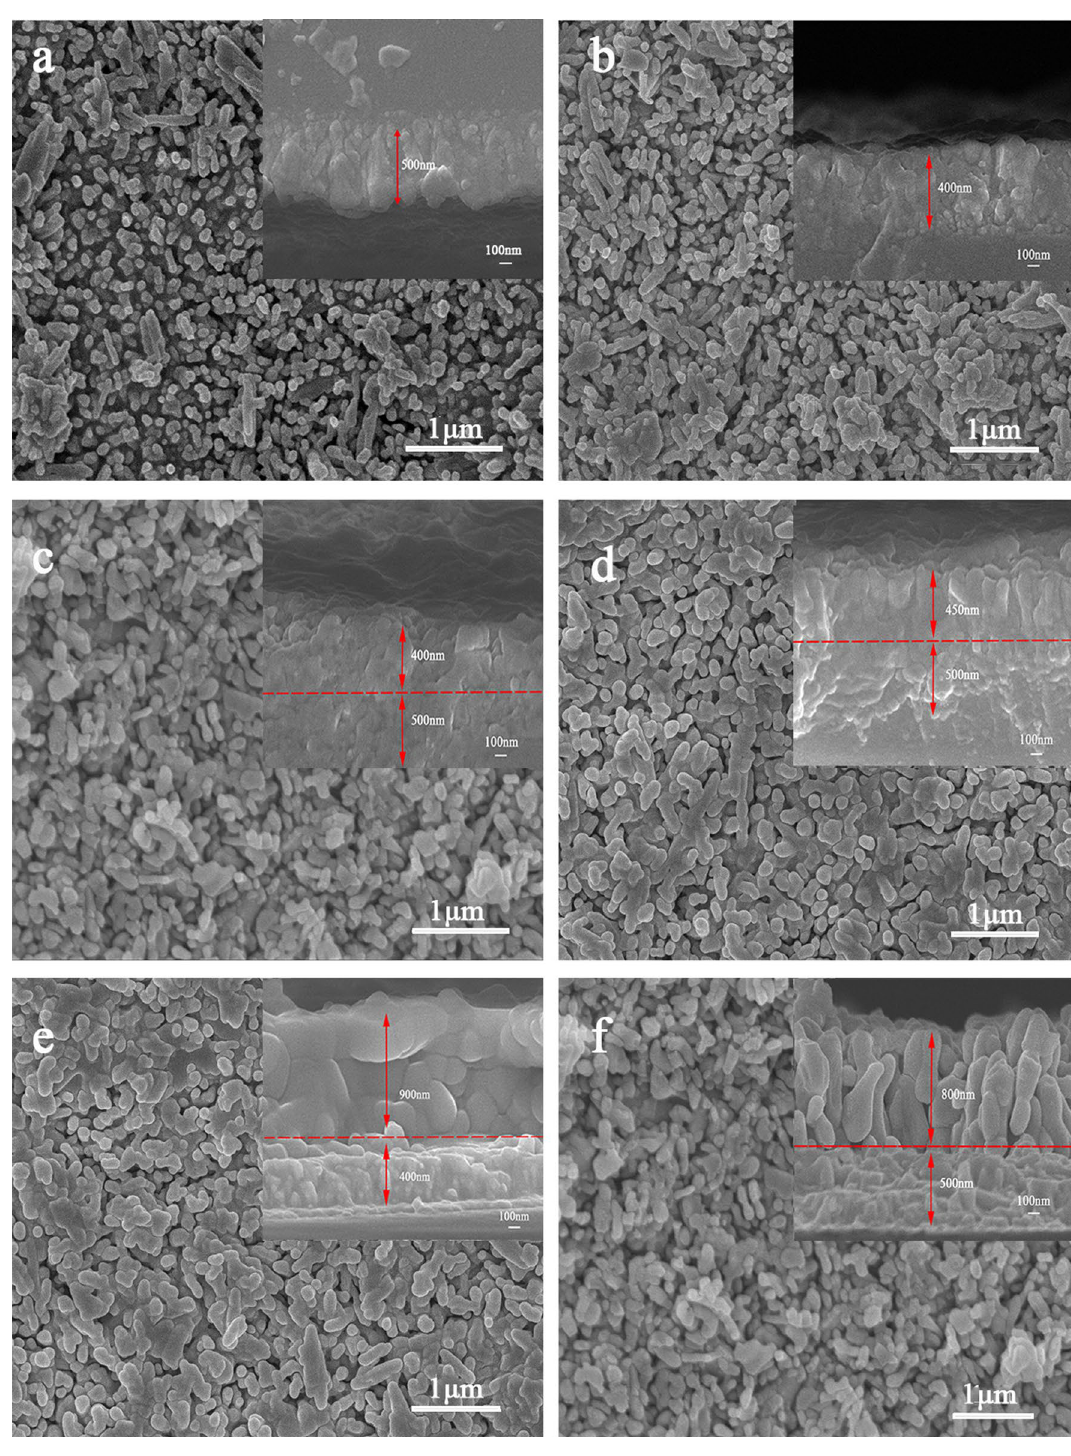
Fig. 2 SEM of a FTO/α-Fe